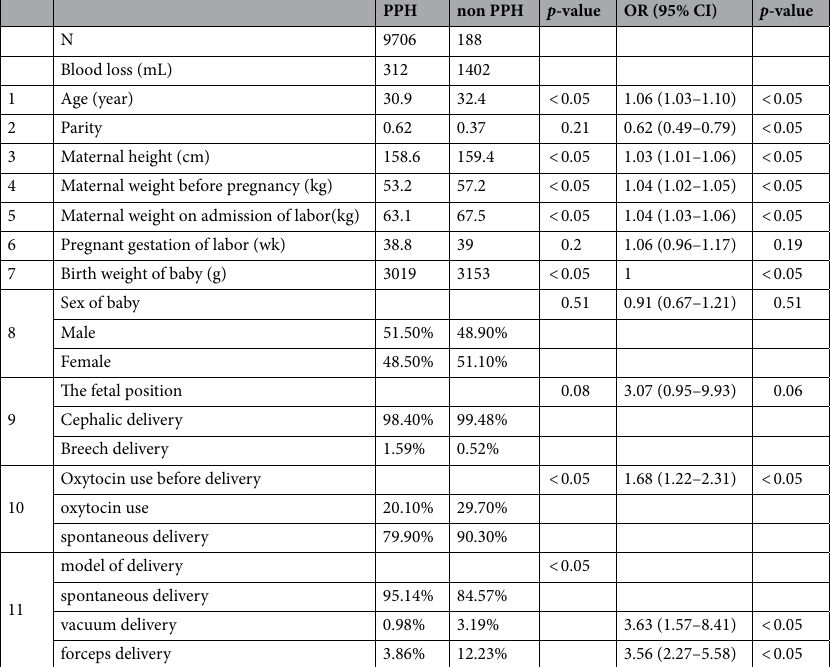
Table 2. Evaluation of the statistical difference between PPH groups (> 1000 mL) and non-PPH groups (< 1000 mL). (1–7) mean value, (8–11) the rate. OR odds ratio, PPH postpartum hemorrhage.